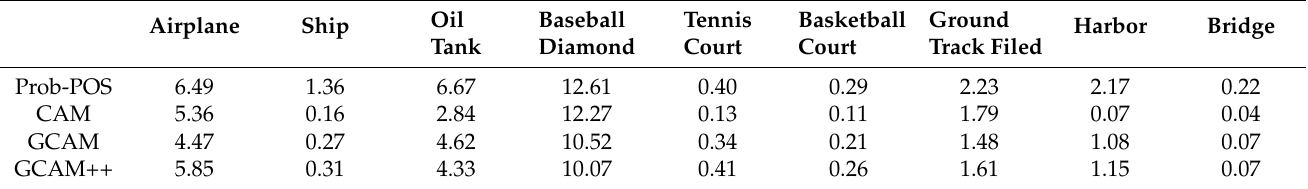
Table 9. Localization capability of the Prob-POS and comparison methods in terms of the evaluation metric of